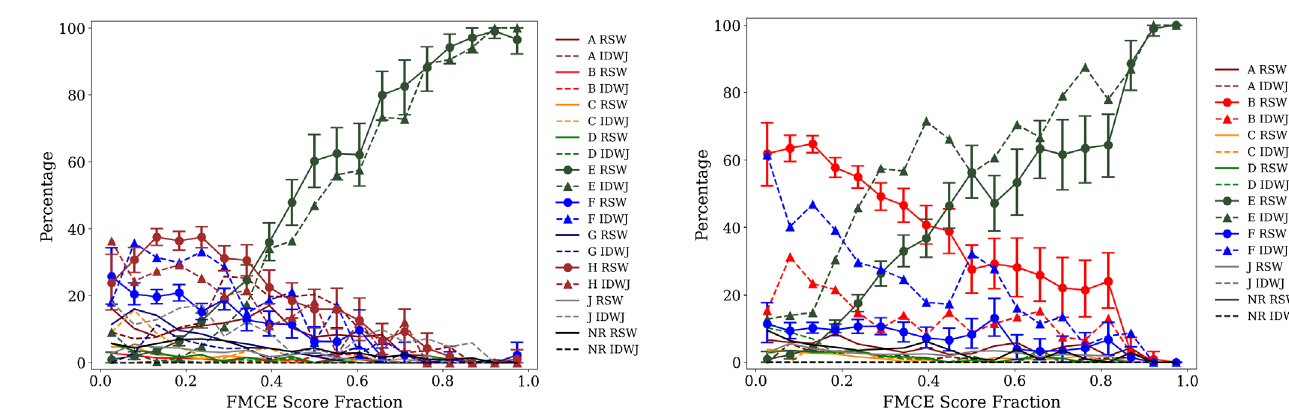
FIG. 8. Item 21 IRCs: the solid lines show the IRCs for the RSW dataset, and the dashed lines show the IRCs for the IDWJ dataset. NR ¼ no response. The error bars on E, F, and H RSW IRCs are the 95% confidence intervals of 10 000 bootstrapped sample datasets based on RSW data described in Sec. III C.